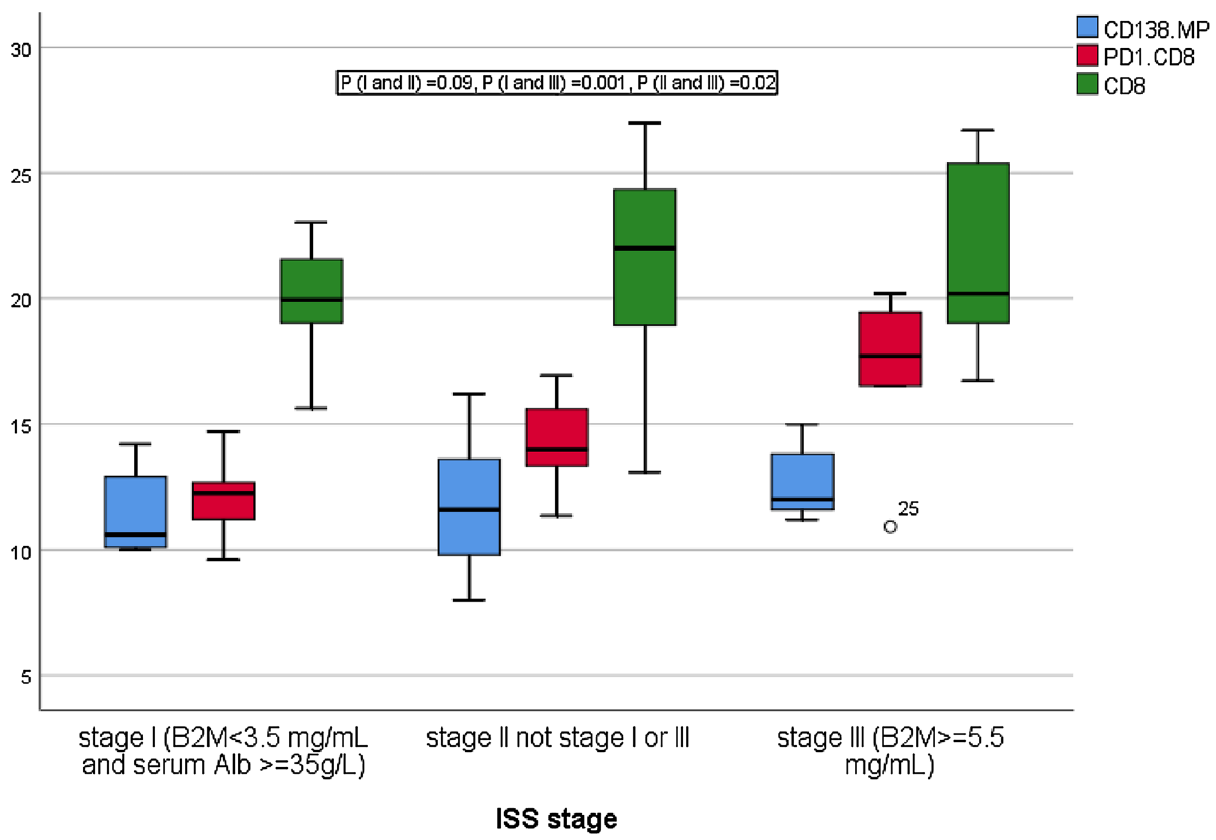
Figure 8. Tukey HSD for post hoc analysis was applied for PD1+CD8+T cells to detect differences across different ISS stages; significant accumulation of PD1+CD8+T cells was found in stage III compared to stage I (mean difference = 5.04, p = 0.001), and stage II (mean difference = 2.9, p = 0.018), while no significant difference between stage I and II (mean difference = 2.1, p = 0.07), Bonferroni correction was applied to adjust p-values to be 0.09, 0.020, and 0.001 for differences of estimated marginal means between stages I and II, II and III, and III and I